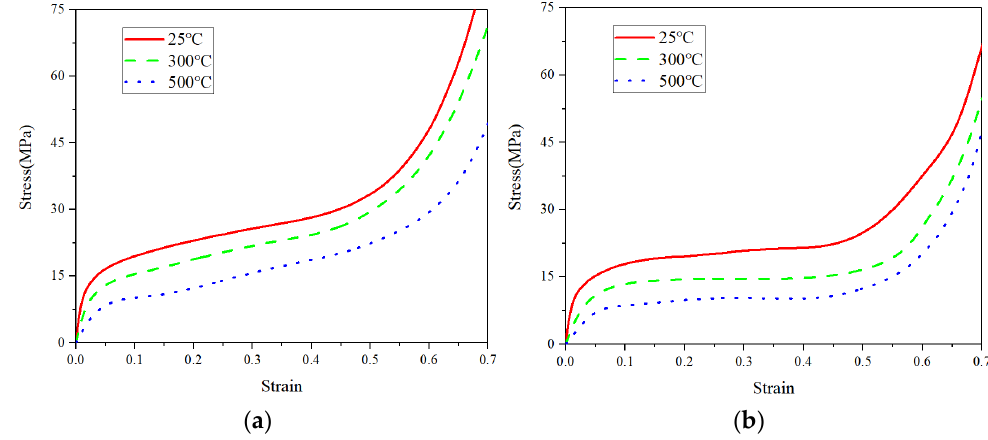
Figure 9. Stress–strain curves of copper foams with ( a ) uniform pores and ( b ) graded pores at different temperatures. The relative densities of the uniform and graded copper foams are 0.42 and 0.37, respectively.